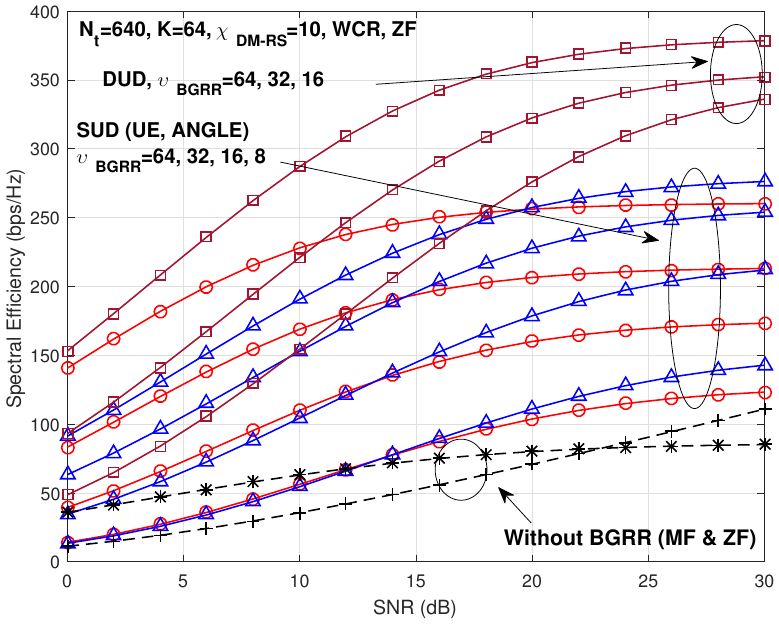
Figure 13. SE (bps/Hz) versus SNR (dB), when N t = 640, K = 64, χ DM − RS = 10, υ BGRR = 64,32,16,8, ZF group precoding. Red solid lines with ’ O ’ marks are the UE based grouping and blue solid ’ (cid:52) ’ marks are the angle based